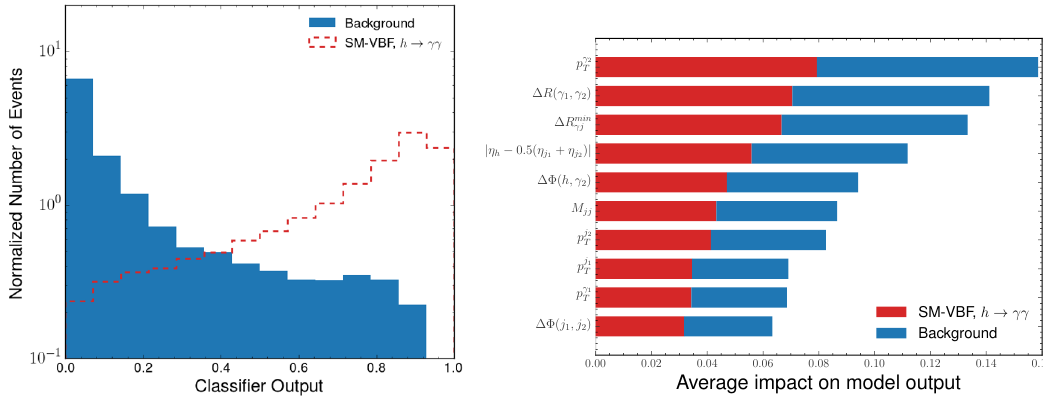
Figure 5 . Left panel shows the classification output for the diphoton channel and the right panel shows the average SHAP value for ten leading parameter that is used in the training. Red shows the signal and blue represents the background in both figures.